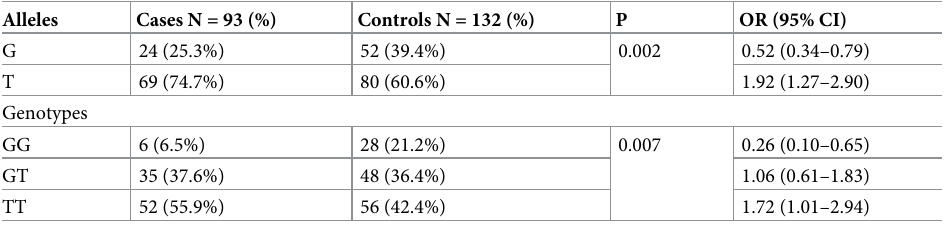
Table 2. Genotype distribution and allele frequencies of CRH-R1